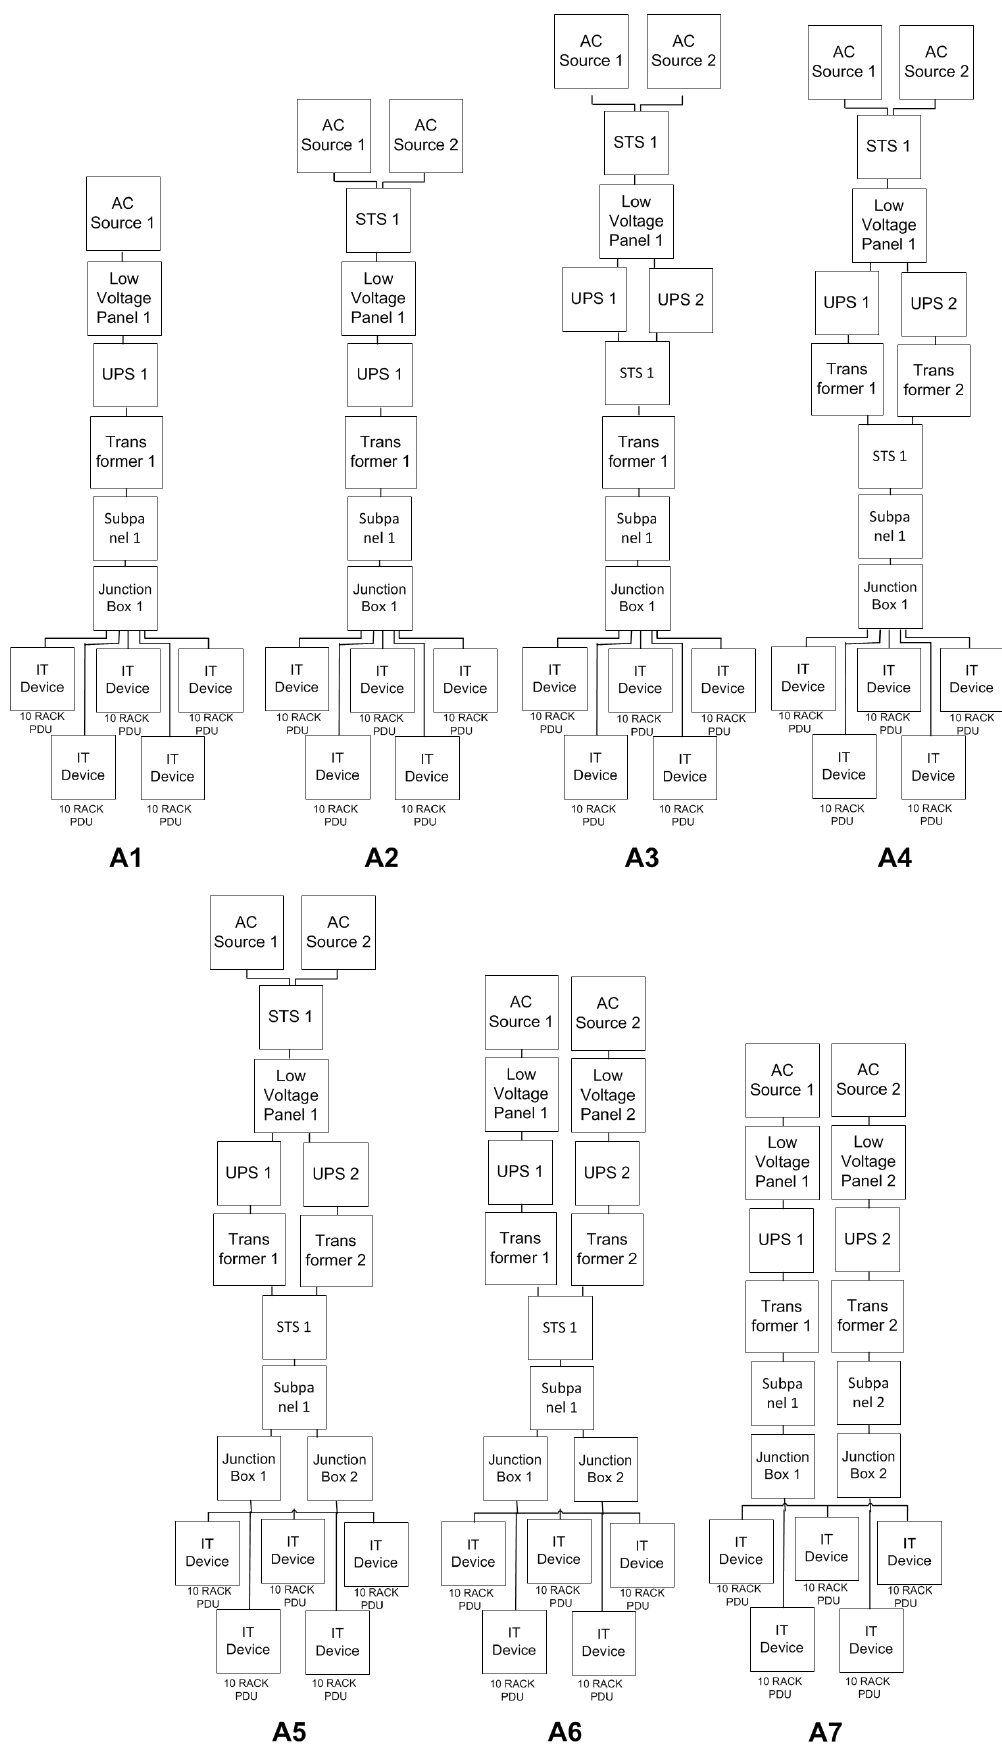
Figure 8. Architectures A1 to